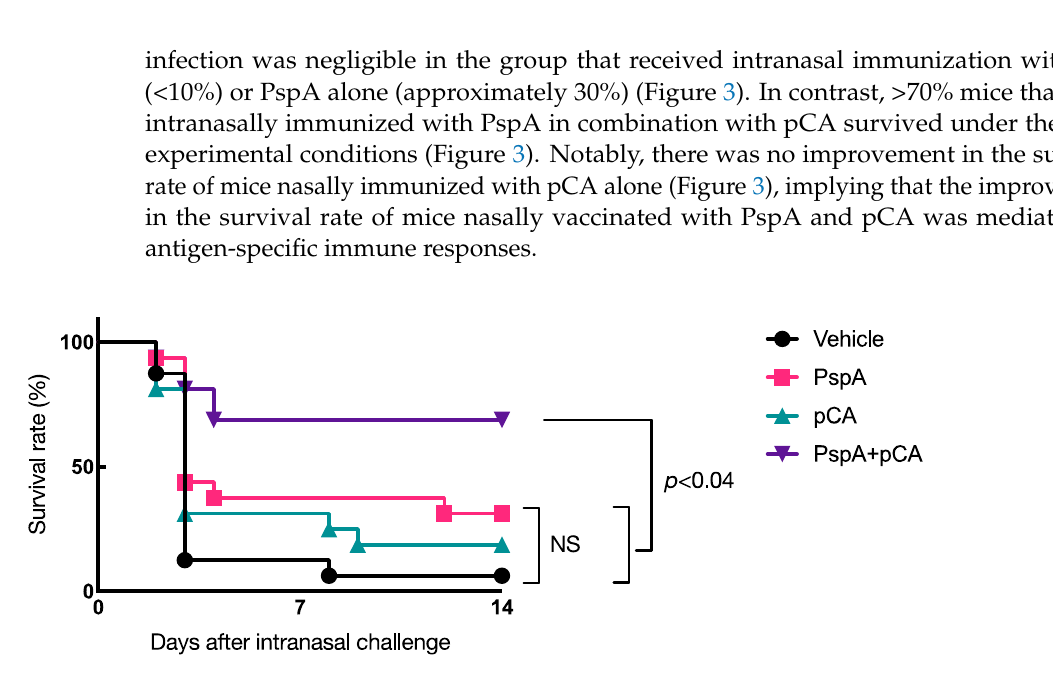
Figure 3. Protective effect of intranasal vaccination with PspA and pCA on the survival rate of mice against pneumococcal infections. BALB/c female mice were nasally immunized with vehicle (PBS), PspA alone (5 µ g/mouse), pCA alone (100 µ g/mouse), or PspA (5 µ g/mouse) in combination with pCA (100 µ g/mouse) on days 0, 7, and 14. Seven days after the last immunization, BALB/c female mice were respiratory challenged with Streptococcus pneumoniae (5.0 × 10 6 colony forming units/mice). Survival was monitored for 14 days after challenge. Data were collected from two independent in vivo infection experiments. Vehicle, n = 16; PspA alone, n = 16; pCA alone, n = 16; PspA plus pCA, n = 16. Significant differences in the survival rate among the groups were assessed using the Mantel–Cox test. The p-values are shown in the figure.